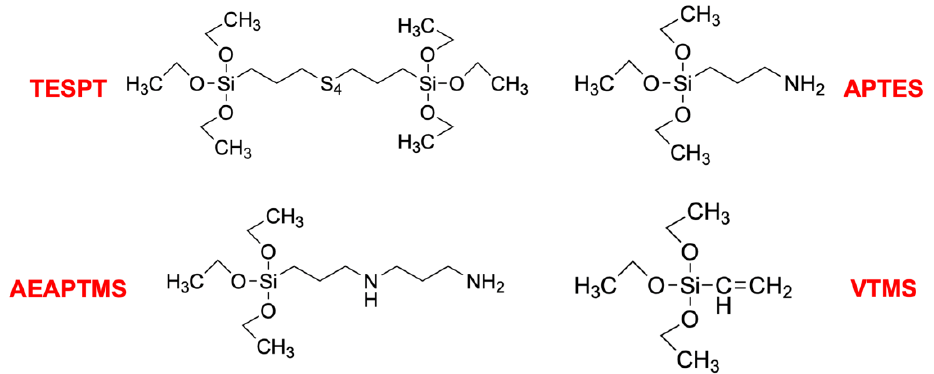
Figure 1. Type of silane coupling agents used for NR/HNT composites.